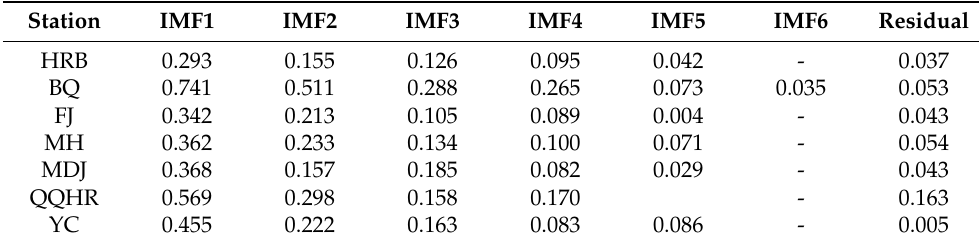
Figure 7. The forecast results and the absolute error of IMFs and residual series of each station by CEEMDAN-LSTM (the blue line represents the absolute error, and the red line represents the forecasting value). Table 8. The MAE of IMFs and residual series at each station.